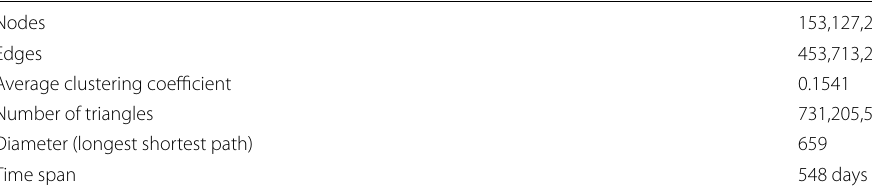
network graph. The time-graph does not only track the evolution of the space dimen- sion, but it also facilitates efficient retrieval of time-dependent Projected graphs. Table 7 describes the statistics of the Whole-graph in the graph database.